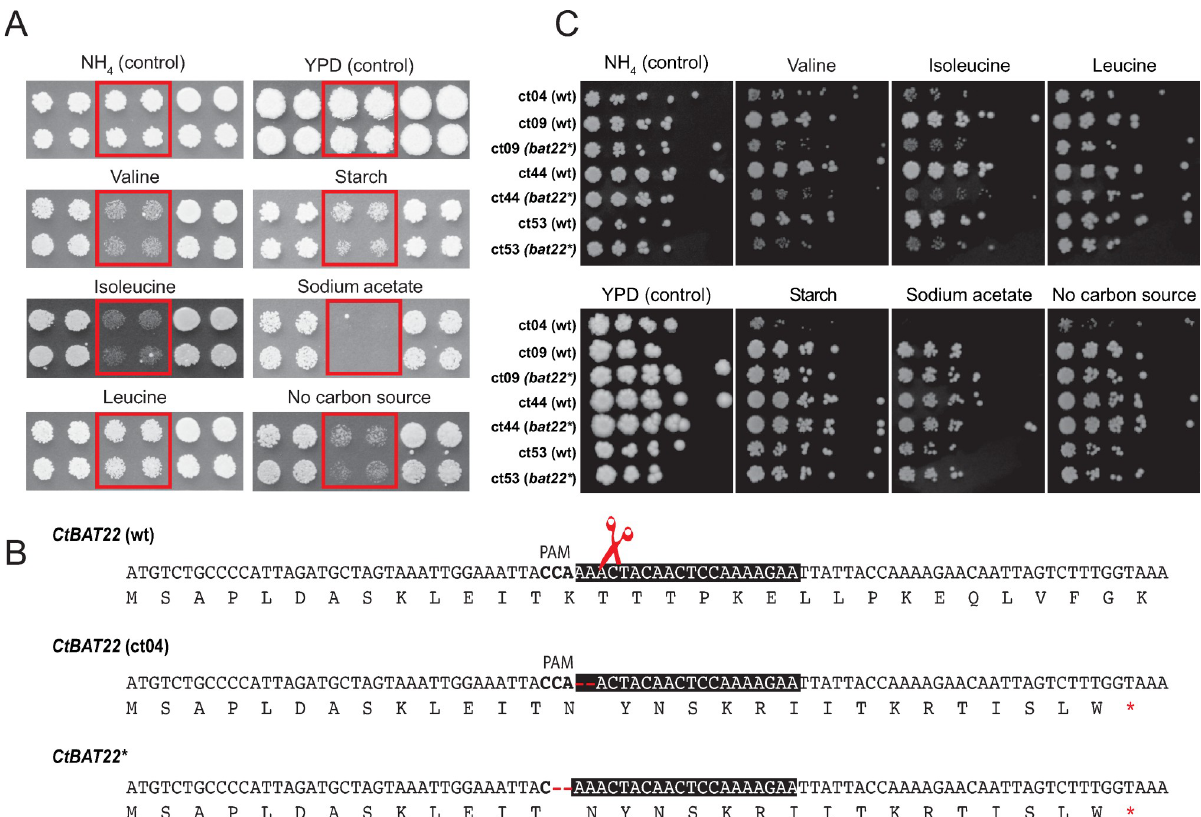
Fig 4. Disrupting BAT22 prevents growth of C . tropicalis on branched chain amino acids as a sole nitrogen source. (A) Phenotype analysis of C . tropicalis isolates. Growth of C . tropicalis ct04 is shown on solid media. Strains were grown in 2x2 arrays; two biological replicates (top and bottom rows), with two technical replicates each (left and right columns), of each strain were tested. C . tropicalis ct04 replicates are outlined with red boxes. C . tropicalis ct04 cannot utilize valine or isoleucine as a sole nitrogen source and also exhibits a growth defect on solid media with 2% starch or 2% sodium acetate as the sole carbon source, or on solid media without a carbon source provided. (B) Editing of BAT22 . Plasmid pCT-tRNA-BAT22 was generated to edit the wild type sequence of BAT22 ( CTRG_06204 ) using CRISPR-Cas9. The sequences of the reference C . tropicalis BAT22 ( CtBAT22 (wt)), BAT22 from C . tropicalis ct04 ( CtBAT22 (ct04)) and edited BAT22 ( CtBAT22 � ) are shown. The guide sequence is highlighted with a black box, the PAM sequence is shown in bold, and the Cas9 cut site is indicated with a red scissors. C . tropicalis isolates ct44, ct09 and ct53 were transformed with pCT-tRNA-BAT22 and a repair template (RT_BAT22_2bpDel_SNP) generated by overlapping PCR using RT_BAT22_2bpDel_SNP-TOP/BOT oligonucleotides. The repair template contains two 60 bp homology arms and deletes two bases in BAT22 resulting in the same frameshift observed in C . tropicalis ct04. (C) Edited strains have defects in branched-chain amino acid metabolism . 5-fold serial dilutions of C . tropicalis ct04, ct09(wt; bat22 � ), ct44 (wt; bat22 � ) and ct53 (wt; bat22 � ) in the same conditions tested in (A). The edited strains cannot use valine or isoleucine as sole nitrogen